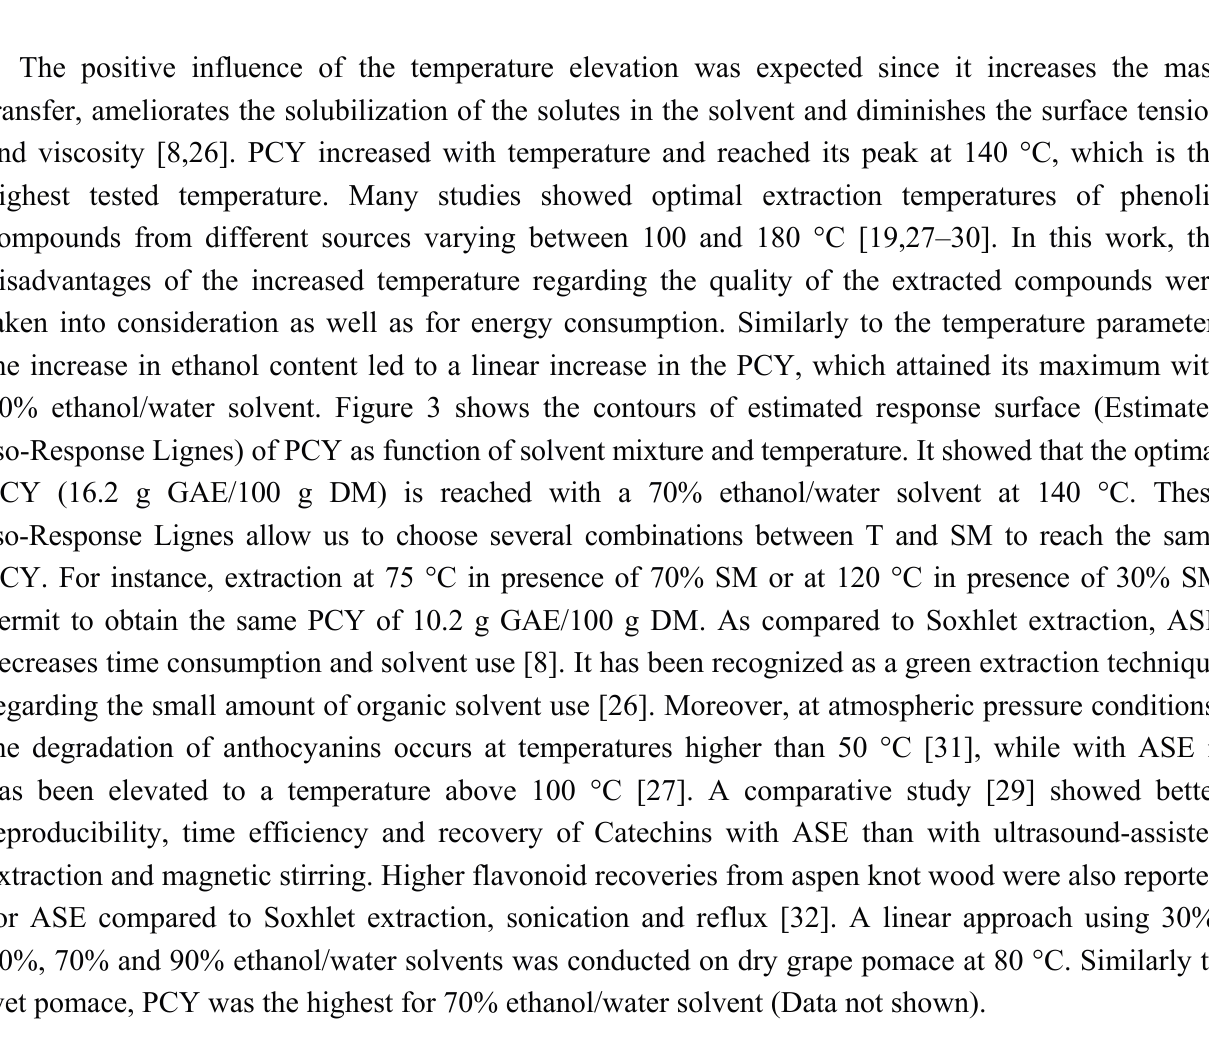
Figure 3. Contours for estimated response surface, showing by the red mark, the optimal extraction parameters for the maximization of the phenolic compounds